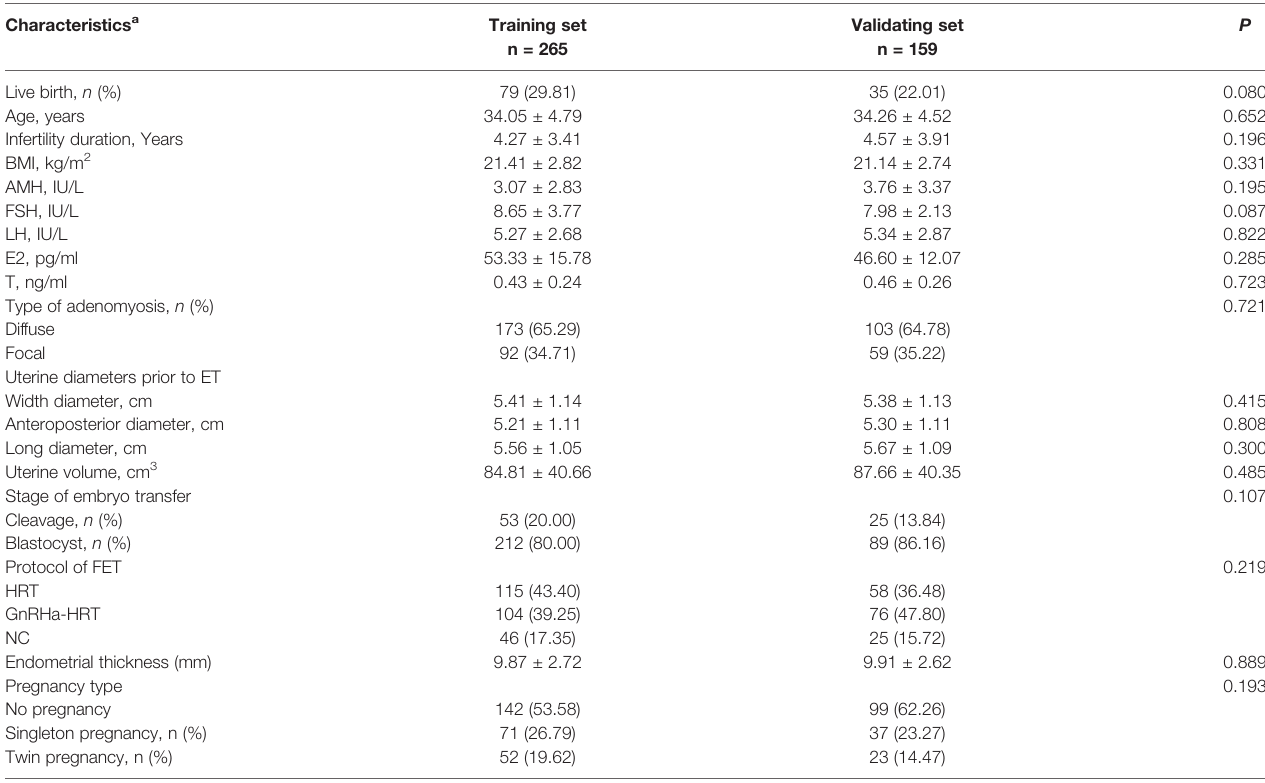
TABLE 2 | Patient characteristics in the training and the validation cohorts. Characteristics a Training